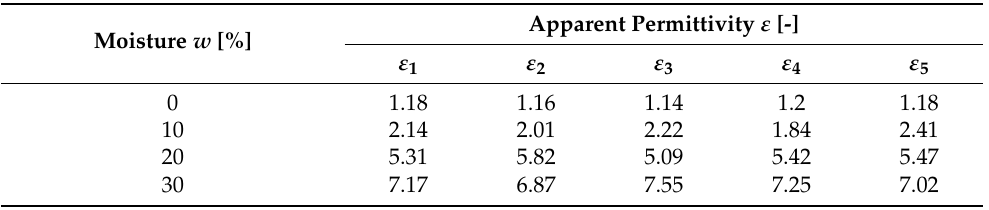
Table 1. Results of the apparent permittivity ε measurements with the FP/mts invasive probe for different values of material moisture w ; 400 c.c.